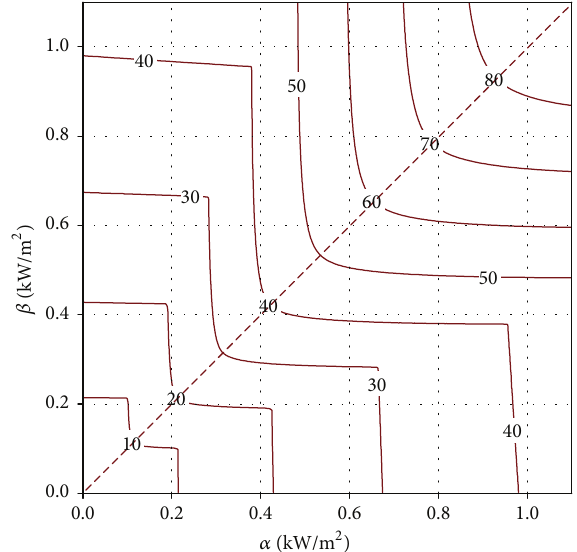
Figure 16: Isopower contours in 𝛼 - 𝛽 plane.